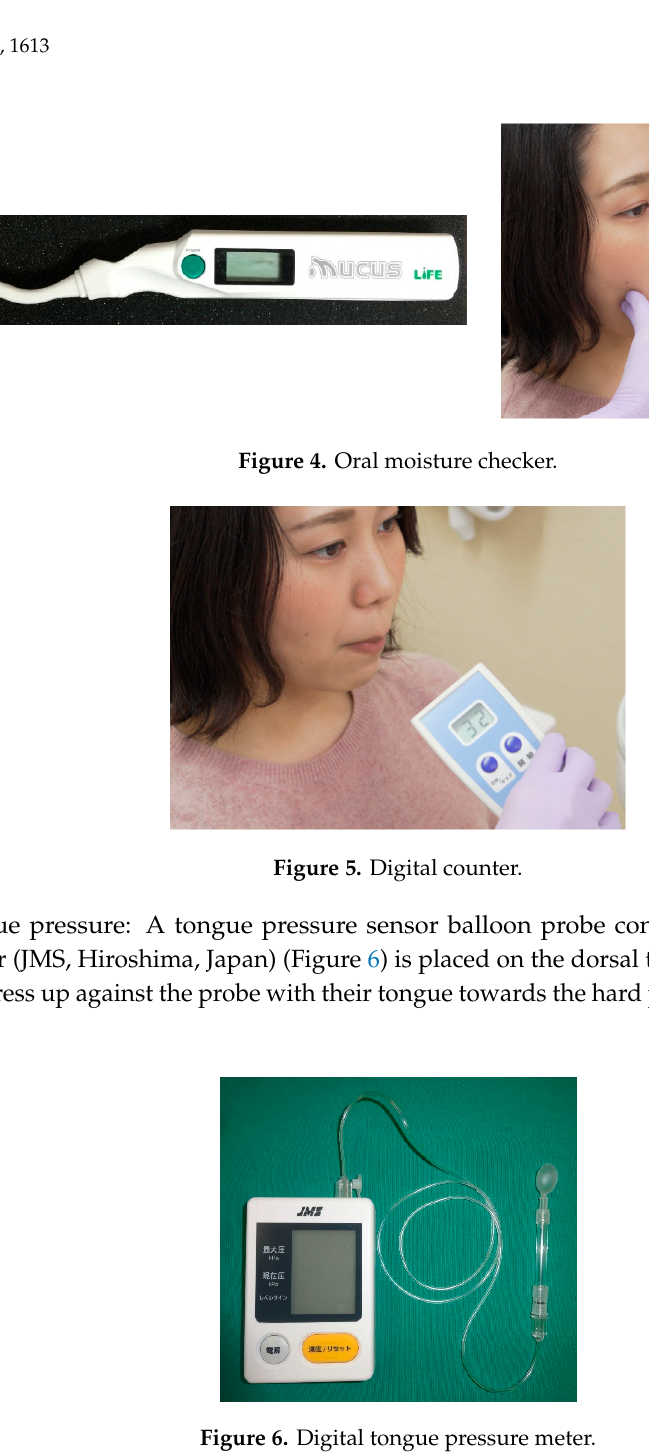
Figure 5. Digital counter Figure 6. Digital tongue pressure meter. Figure 6. Digital tongue pressure